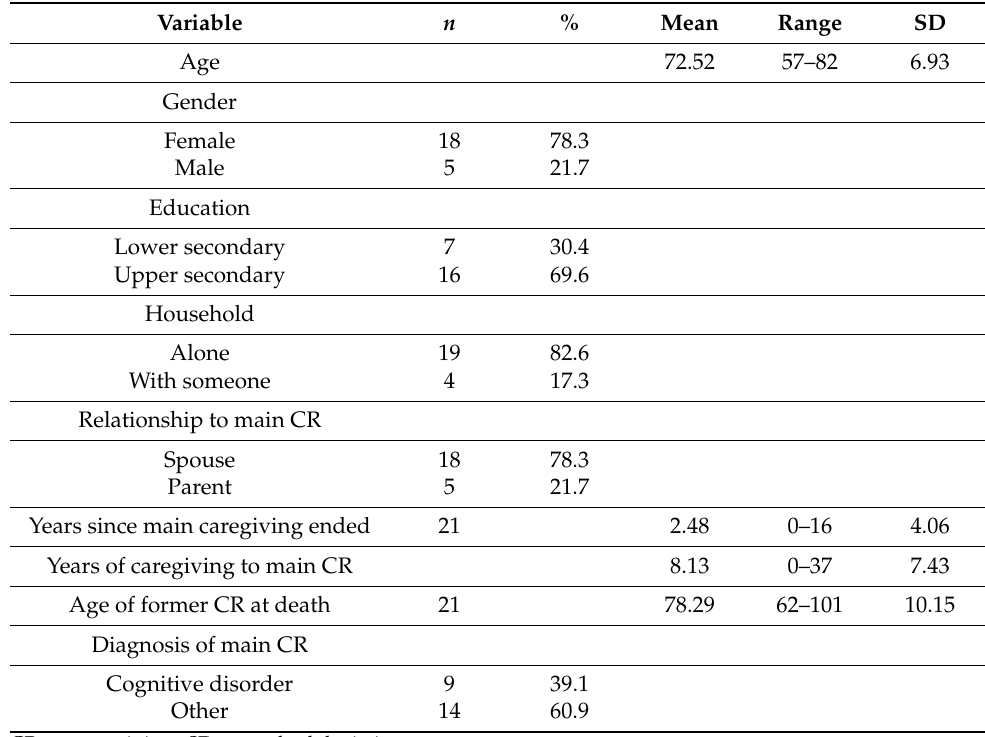
Table 2. Characteristics of final 23 participants at